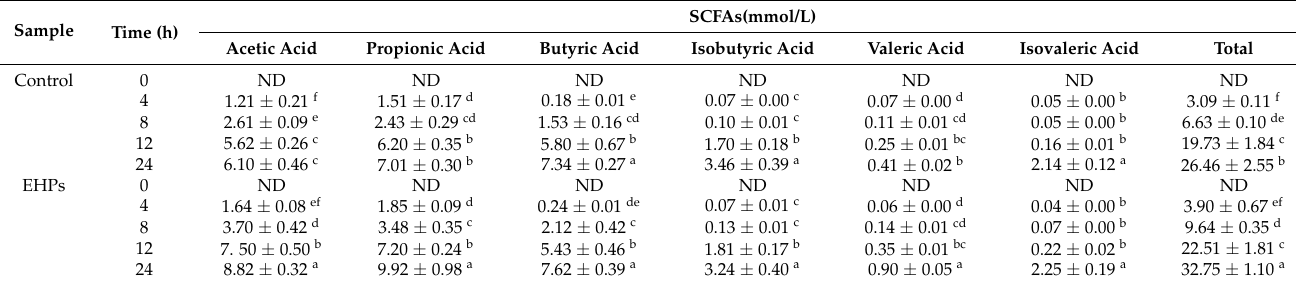
Table 3. Production changes of SCFAs during fermentation in